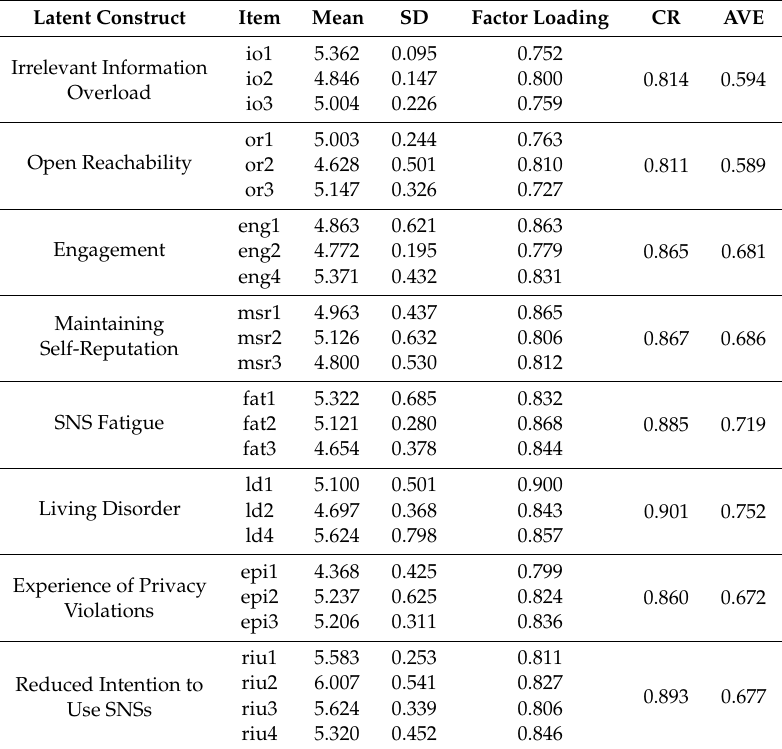
Table 5. Convergent validity results.